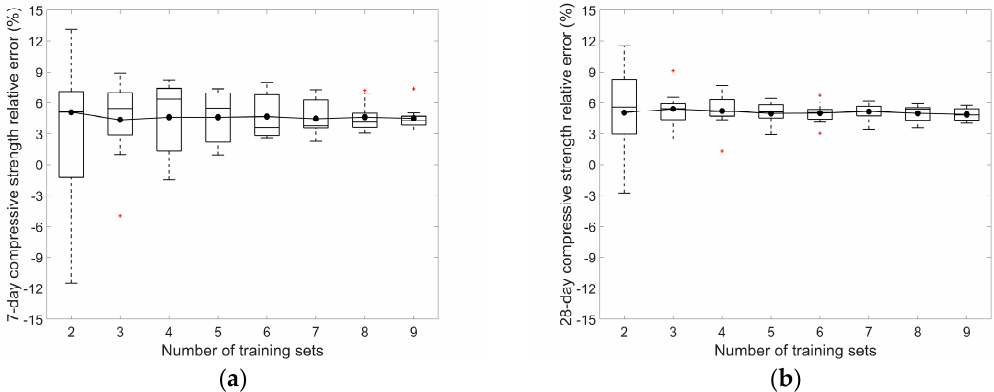
Figure 7. Sensitivity analysis between the number of training sets, and relative error between predicted and tested ( a ) 7-day and ( b ) 28-day compressive strength of group 6.